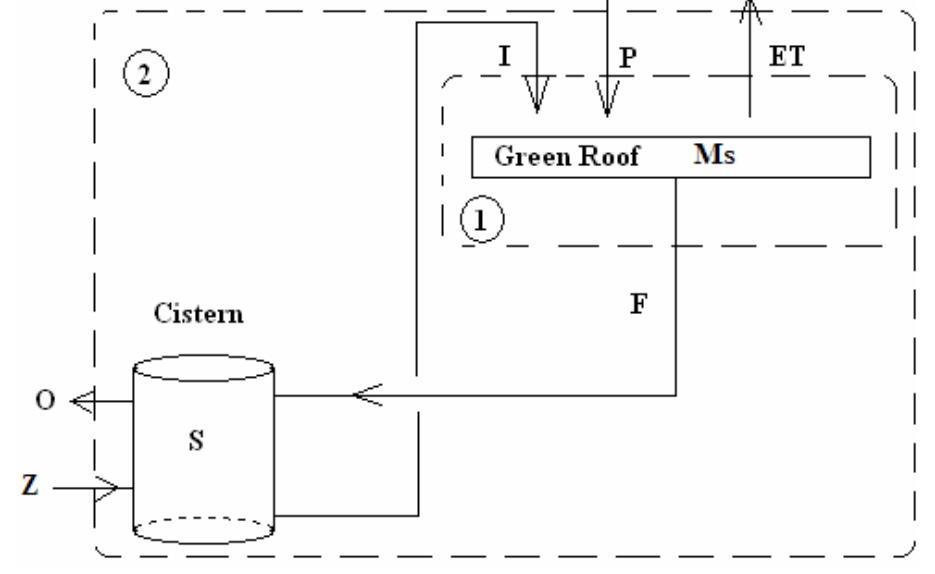
Figure 5. Green roof stormwater treatment system boundaries [10]. The variables are as follows: M S = Media storage (volume/unit area of green roof); P = Precipitation (volume/(unit area of green roof × time)); I = Irrigation (volume/(unit area of green roof × time)); ET = Evapotranspiration (volume/(unit area of green roof × time)); F = Filtrate (volume/(unit area of green roof × time)); S = Cistern storage (volume/(unit area of green roof); Z = Makeup Water (volume/(unit area of green roof × time)); O = Overflow (volume/(unit area of green roof ×